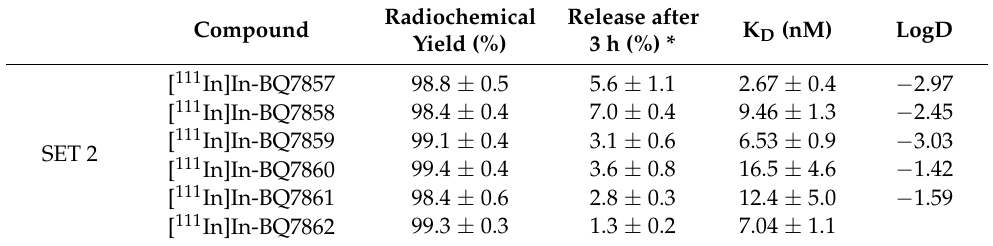
Table 2. Radiochemical yield, the release of free indium-111 after EDTA challenge for 3 h, K D -value, and LogD for the compound [ 111 In]In-BQ7857-62 (SET 2). Measurements were done in triplicate. * the labelled compound was challenged with 1000-fold excess of